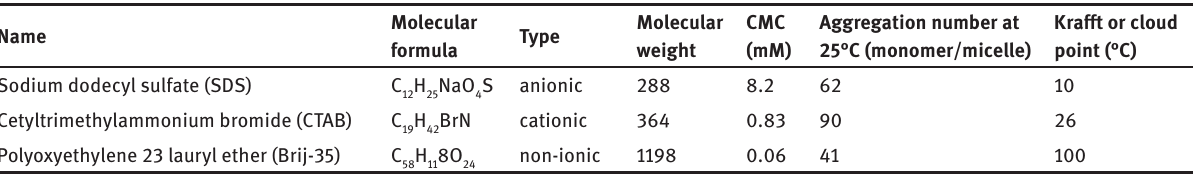
Table 1: Characteristics of the most common surfactants in MLC a